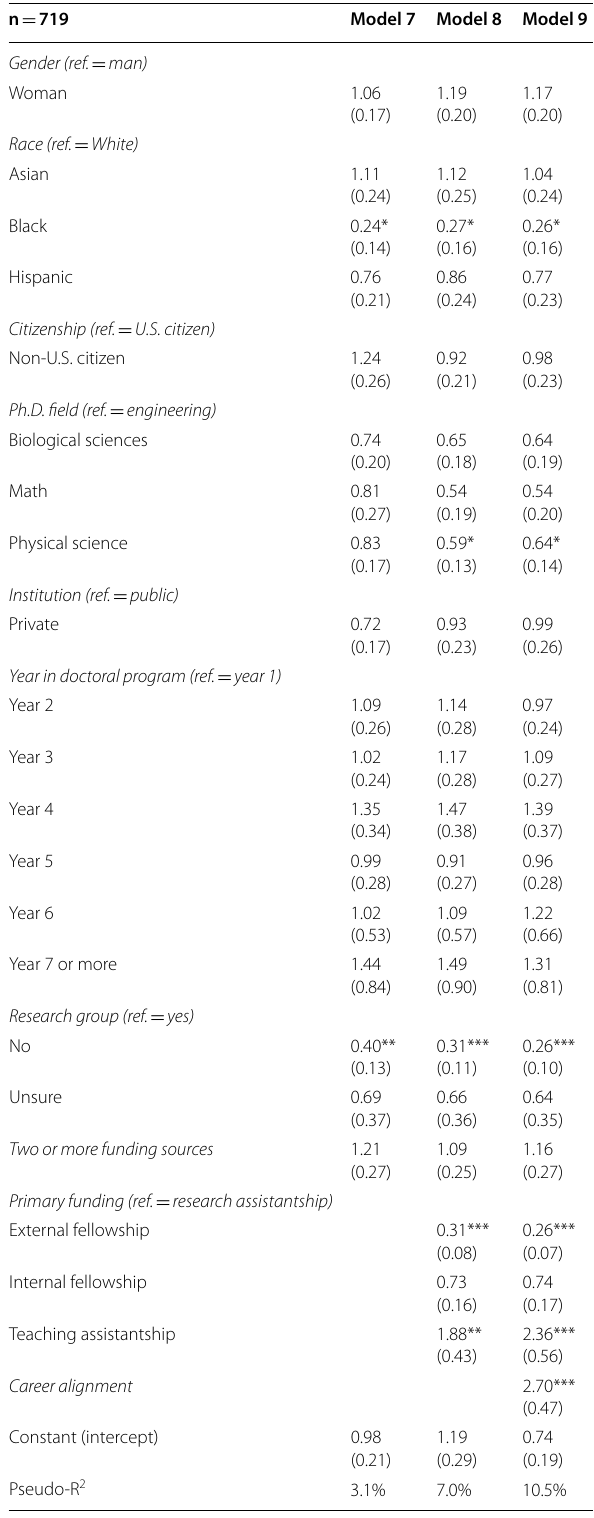
Table 6 Logistic regression of peer training and mentoring